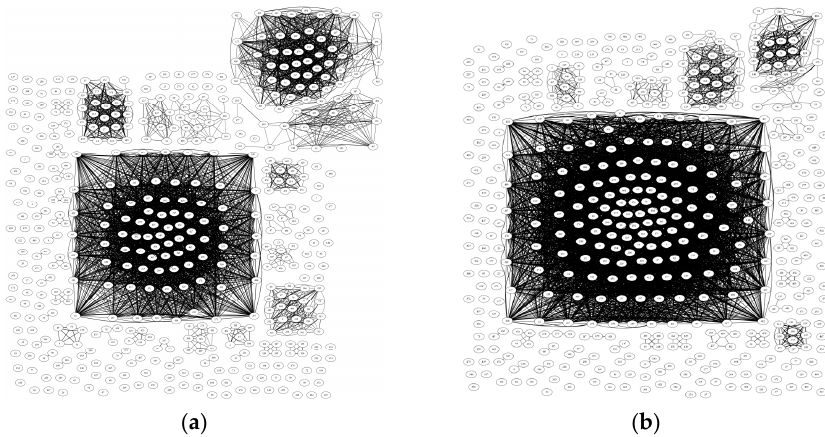
Figure 6. The similarity graph of API calls threshold = 0.4: ( a ) Malware; ( b ) legitimate.